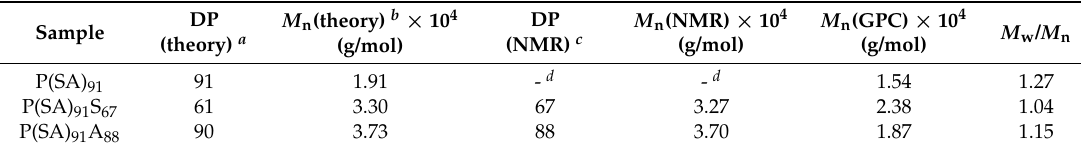
Table 1. Degree of polymerization (DP), number-average molecular weight ( M n ), and molecular weight distribution ( M n /M n